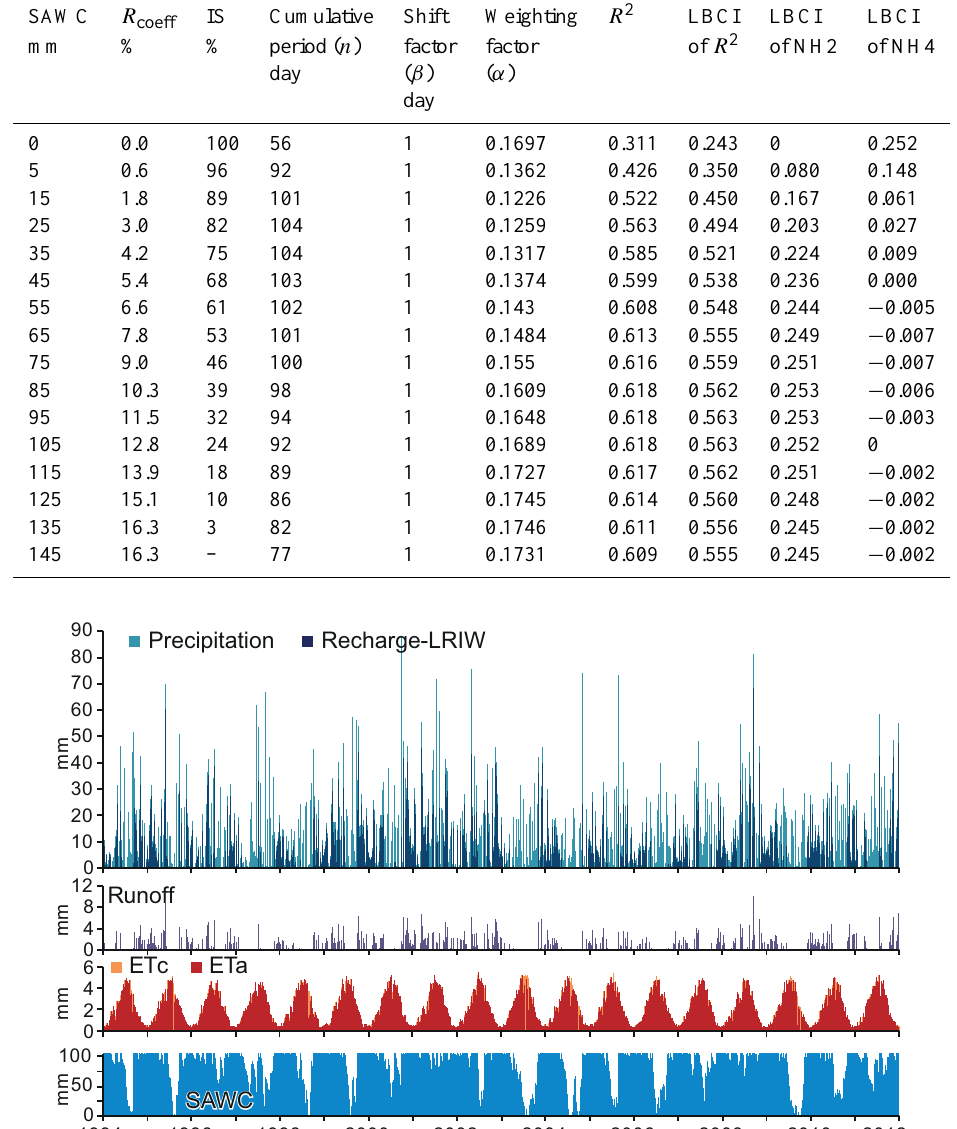
obtained with R LRIW are significantly higher than those